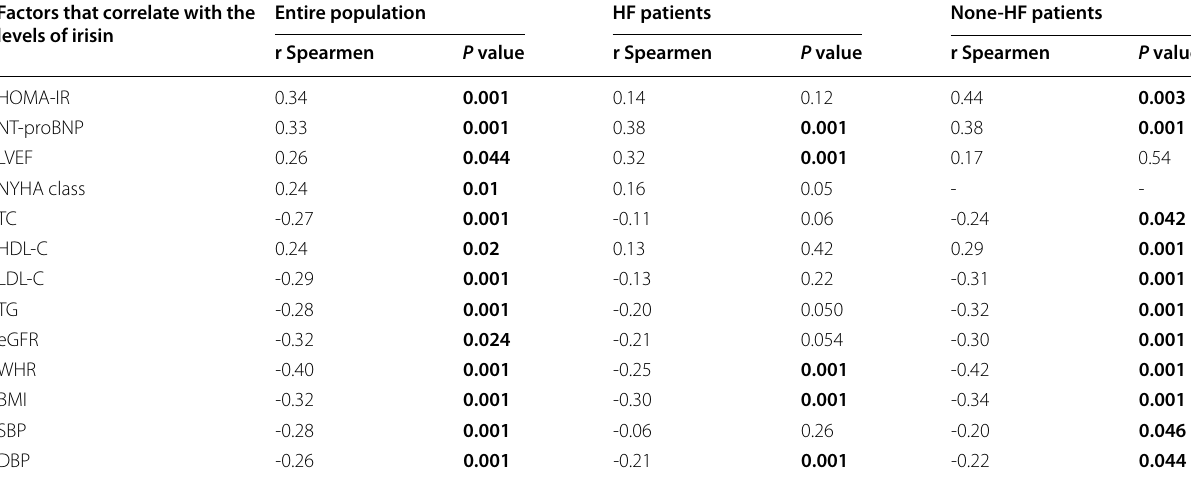
Table 2 Spearmen correlations between irisin levels and other parameters Factors that correlate with the levels of